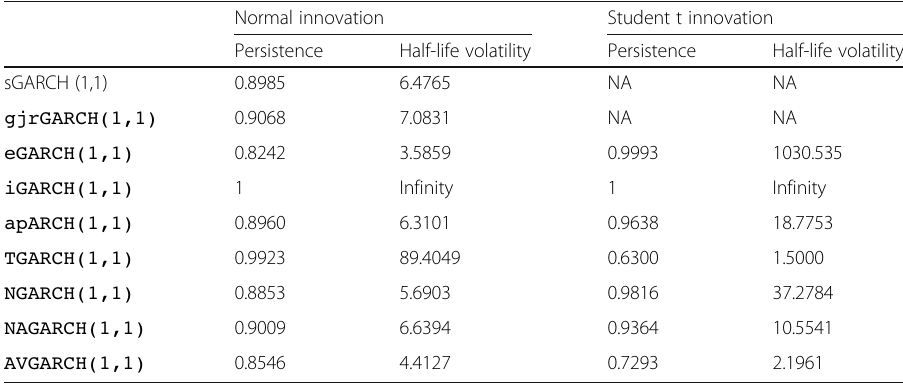
Table 3 Persistence and half-life volatility of log returns of daily stock price of Total Nigeria Plc Normal innovation Student t innovation